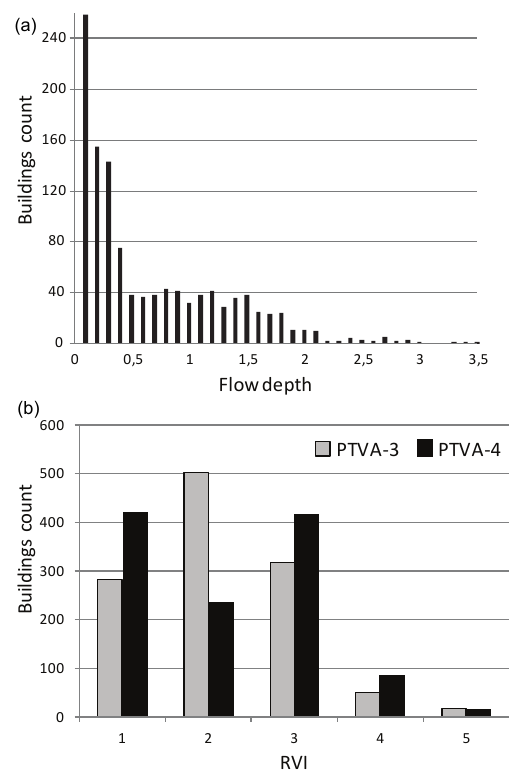
Figure 6. (a) Number of buildings exposed to the different water depth (WD) ranges in Coquimbo Bay in the reconstructed 2015 tsunami scenario. (b) RVI scores obtained for the total 1239 build- ings analyzed after the PTVA-3 and PTVA-4 models.